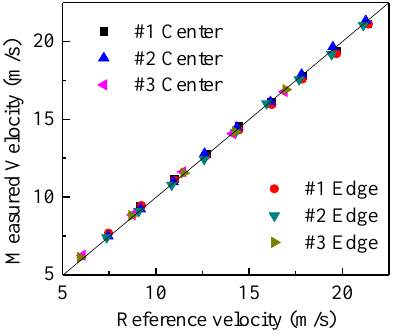
Figure 9. Comparison of measured and reference velocities.